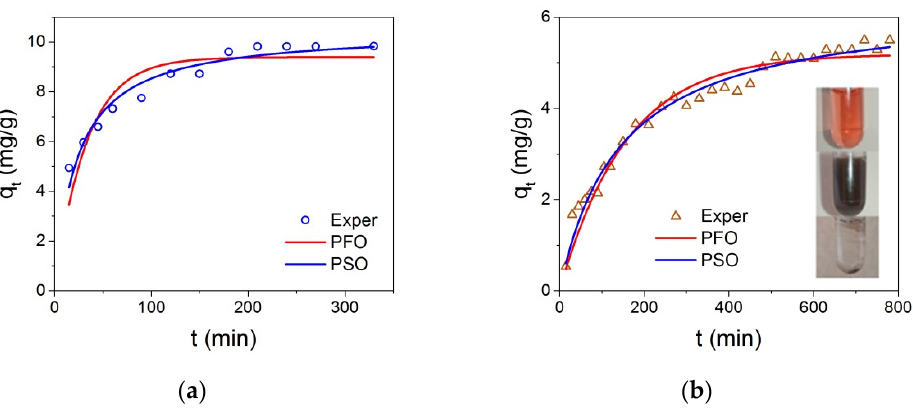
Figure 11. The q t dependence on the Fe 3 O 4 @C@C NPs contact time with MB ( a ) and CR ( b ) dyes, and results of the pseudo-first order (red lines) and pseudo-second order (blue lines) nonlinear modeling. The experimental conditions: C 0 = 30 mg/L, m(NPs) = 3 mg, V = 1.5 mL. Inset in panel b: the photographs of the initial CR water solution (at the top), the same solution with dispersed NPs (at the middle), and after gathering of NPs with the permanent magnet during a few tens of seconds (down).